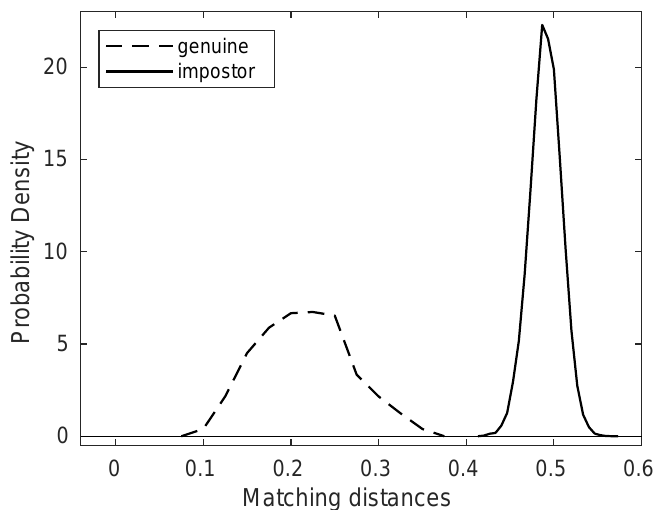
Figure 6. The probability distributions of genuine/impostor matching distances for the com- bined